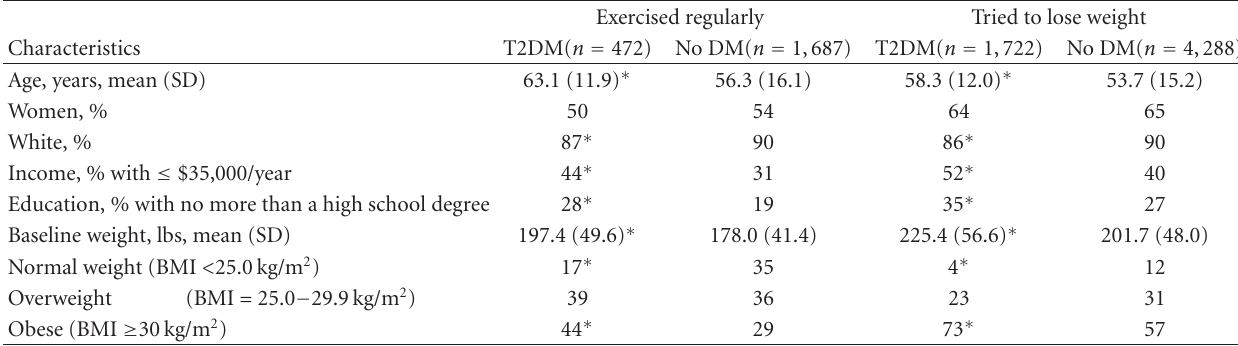
Table 1: Characteristics of SHIELD respondents with and without type 2 diabetes mellitus reporting exercising regularly or trying to lose weight.